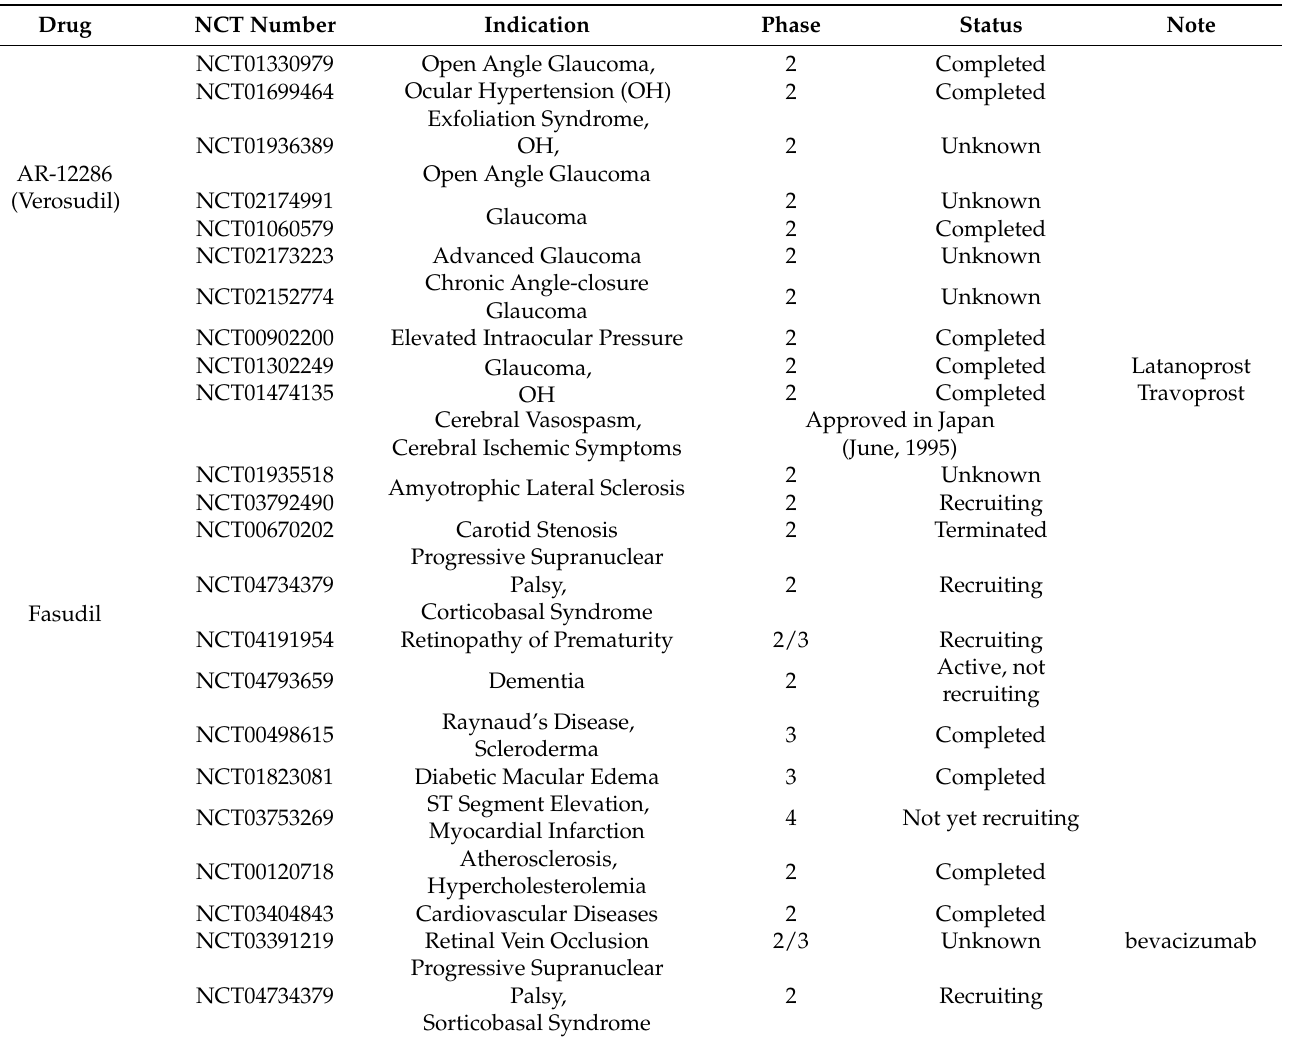
Table 1. Ongoing clinical trials targeting Rho-kinase in various indications 1 .